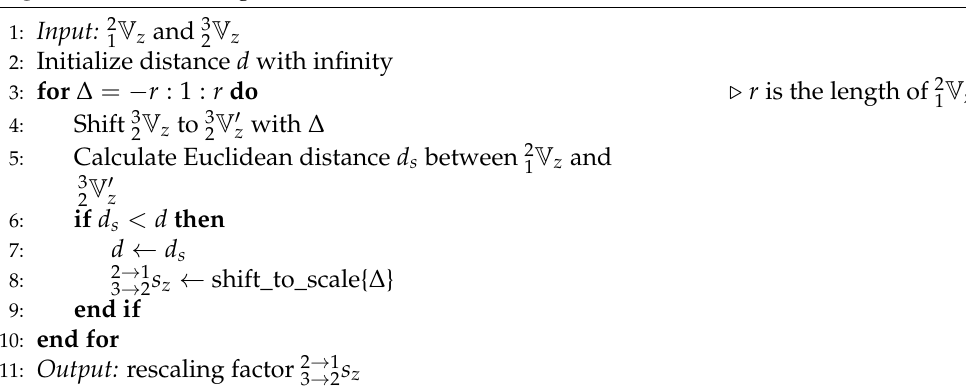
Algorithm 3 Re-scaling for